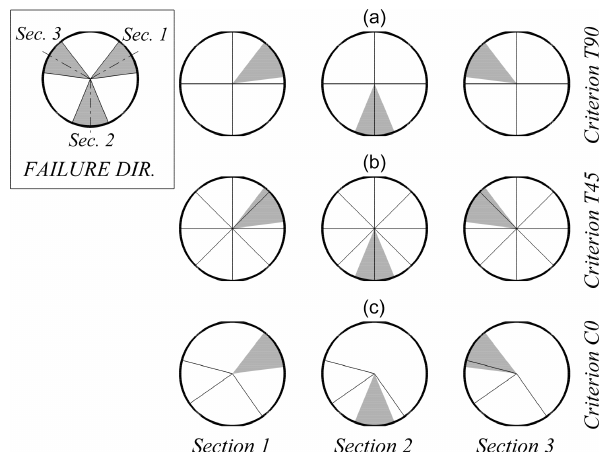
N P x 2 , where n n = 1